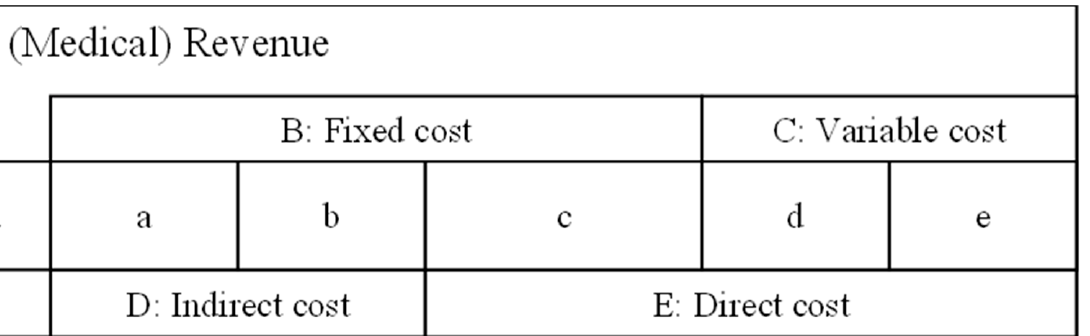
Figure 2. PL structure A: (Medical) Revenue, B: Fixed cost, C: Variable cost, D: Indirect cost, E: Direct cost, α : Medical profit, a: Depreciation for a hospital, b: Maintenance cost for a hospital, c: Labor costs, d: Cost of medical materials, e: Food expenses. A = α + B + C = α + D + E, B = a + b + c, C = d + e, D = a + b, E = c + d + e.